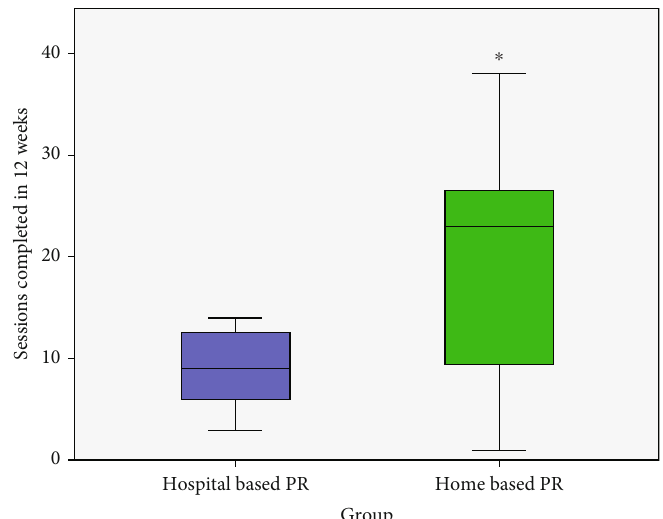
Figure 3: Sessions completed. PR: pulmonary rehabilitation. ∗ Signi fi cant di ff erences in sessions completed between groups, p = : 04